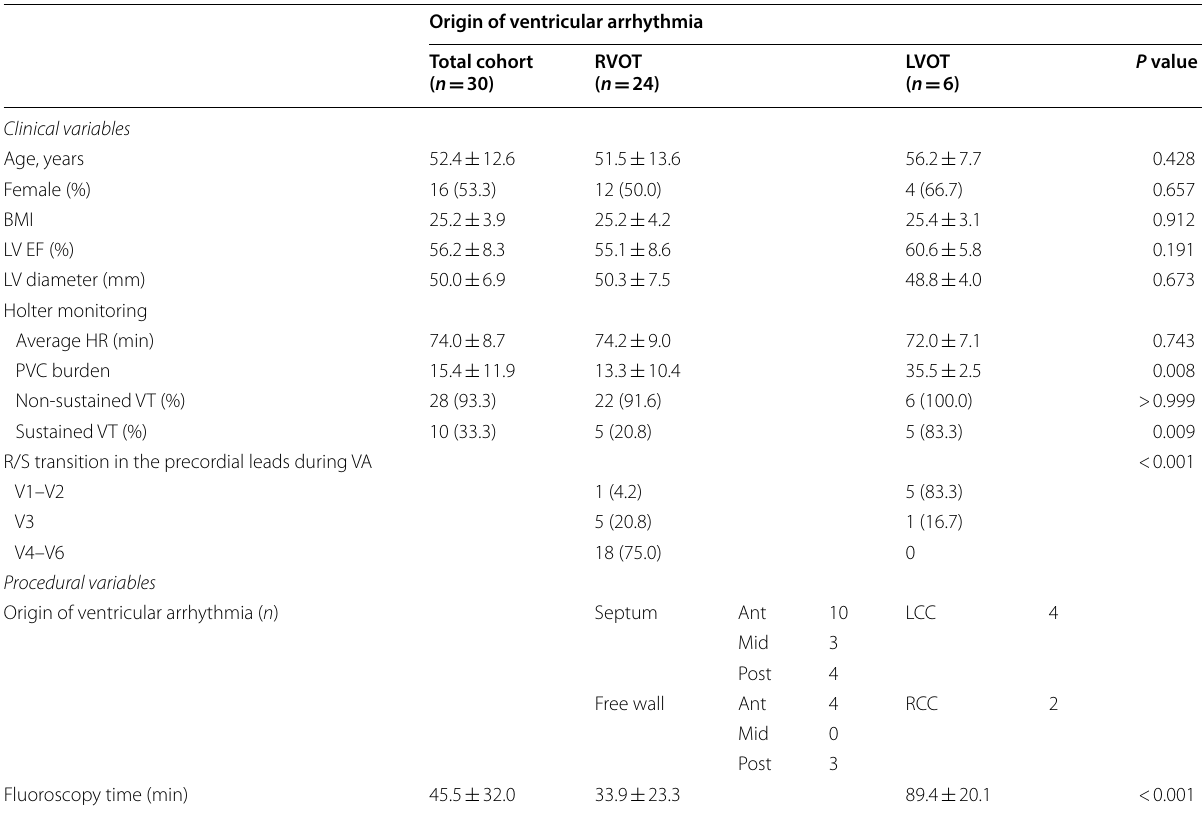
Table 1 Baseline clinical and procedural characteristics of the study subjects